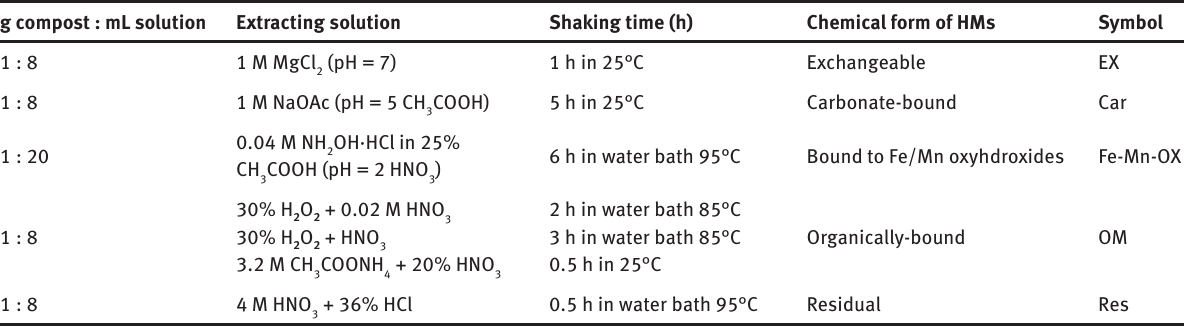
Table 4: Summary of the sequential extraction procedure used in this study.